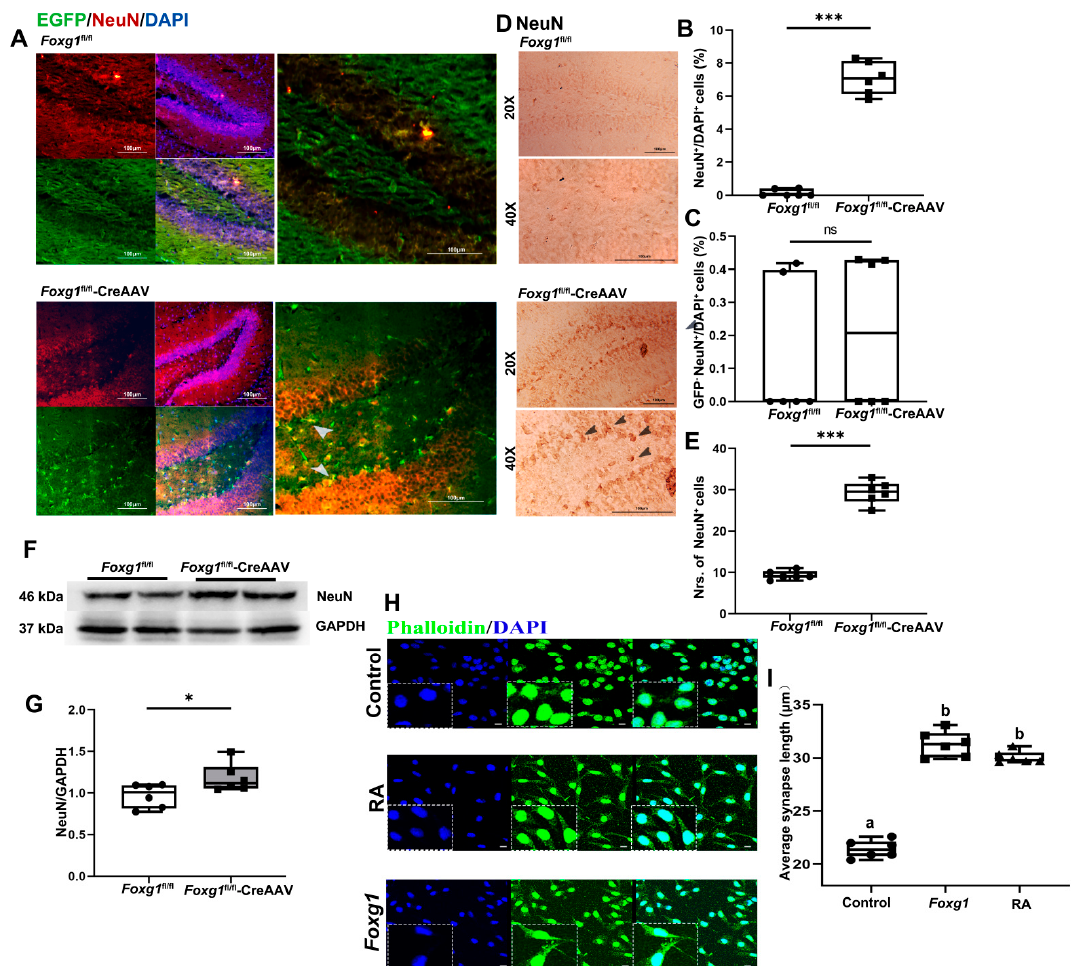
Figure 7. FOXG1 induces final mature of GNs in adult hippocampus DG and increases synaptic plasticity. ( A ) Expression patterns of NeuN-expressing GNs in the hippocampal DG of Foxg1 genotype mice were assessed with immunofluorescence. Red = NeuN; Green = EGFP-labeled FOXG1; Blue = DAPI. Scale bars = 100 μ m. Arrow heads: newly generated GNs with FOXG1 activation. ( B ) Levels of total GNs in adult hippocampus are showed as %NeuN + /DAPI + cells. ( C ) Levels of endogenous GNs in adult hippocampus are showed as %GFP - NeuN + /DAPI + cells. ( D ) Expression patterns and ( E ) qualification of total GNs in adult hippocampus were studied with immunohischemisitry. Scale bars = 100 μ m. ( F , G ) Hippocampal lysates of the two genotype mice were immunoblotted using an antibody against NeuN. GAPDH was used as the loading control. Values are expressed as means ± S. E. M. For each group, n = 6. Significant levels set at * p < 0.05, *** p < 0.001 noted difference between Foxg1 fl/fl and Foxg1 fl/fl -CreAAV animals. ( H ) Fluorescence microscopic analysis of differentiation-related morphological changes of N 2 A cells by stained the F-actin cytoskeleton with fluorescently labeled phalloidin. Green = Phalloidin; Blue = DAPI. As positive control, cells were differentiated with 10 μ M RA. Scale bars = 25 μ m. ( I ) Quantification of the average neurite lengths are illustrated in the column diagrams. Values are expressed as means ± S. E. M. For each group, n = 6. Different letters indicate statistical differences in mean values among groups ( p < 0.05). ns—not significant.